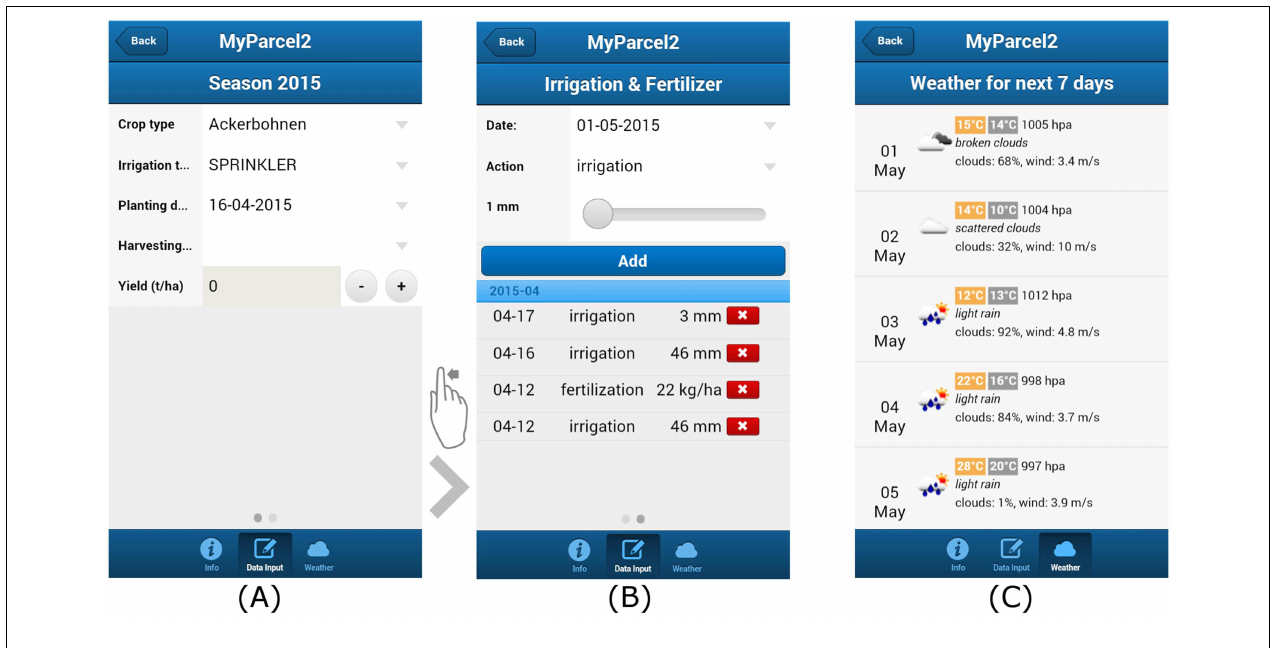
FIGURE 9 | Data input panels (A,B) and weather data (C). Using panel (A) farmers can change the crop and irrigation type, dates of planting and harvest, crop yield. In (B) farmers can log their irrigation (used for the soil water balance) and fertilizer applications; this also